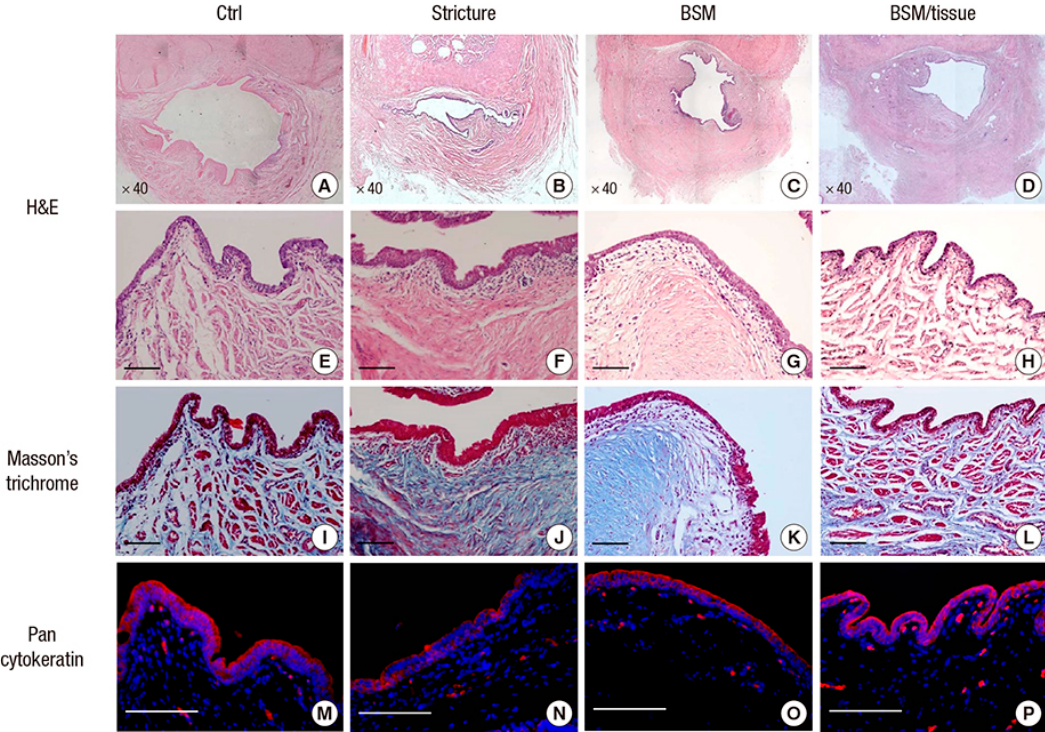
Figure 4. Histological and immunohistochemical analysis of urethra specimens in three groups: stricture model (one month following excision of a longitudinal strip of the urethra), ventral onlay urethroplasty repair using an acellular Bladder Submucosa scaffold (BSM), and repair using both BSM and autologous urethral tissue. It was shown that using an acellular BSM scaffold combined with an autologous urethral tissue graft resulted in a complete epithelialization, compact muscular layers, and progressive infiltration by vessels in the regenerated urethra. In contrast, the BSM grafts alone revealed keratinized epithelium, abundant collagenous fibrous connective tissue, and were devoid of bundles of circular smooth muscle. Low ( A–D ) and high-magnification ( E – H ) H&E images, Masson’s Trichrome images ( I – L ), and Pan-cytokeratin immunofluorescent images ( M – P ) for each of the three groups